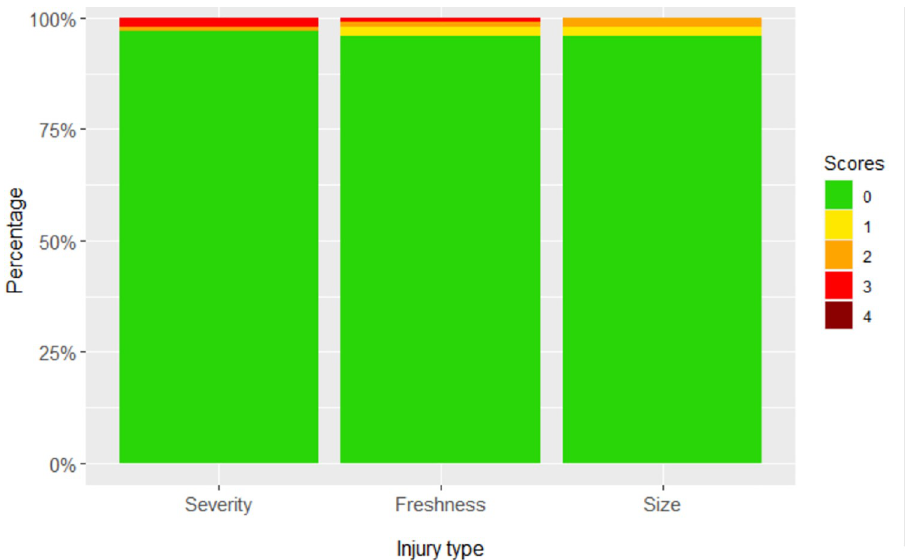
Fig 2. Stacked bar graphs of frequency of flank injury scores. Severity (0, 96.2%; 1, 0.3%; 2, 1.1%; 3, 2.4%), freshness (0, 96.2%; 1, 1.9%; 2, 1.2%; 3, 0.5%; 4, 0.1%) and size (0, 96.4%; 1, 1.7%; 2, 1.9%) of flank biting lesions are shown. (See S1 File for score